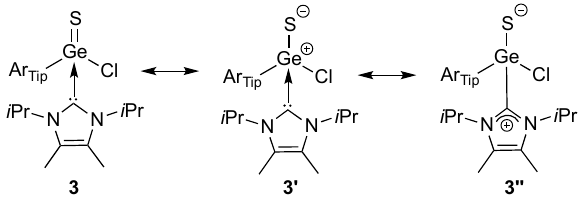
Figure 4. Resonant structural formula of 3 .